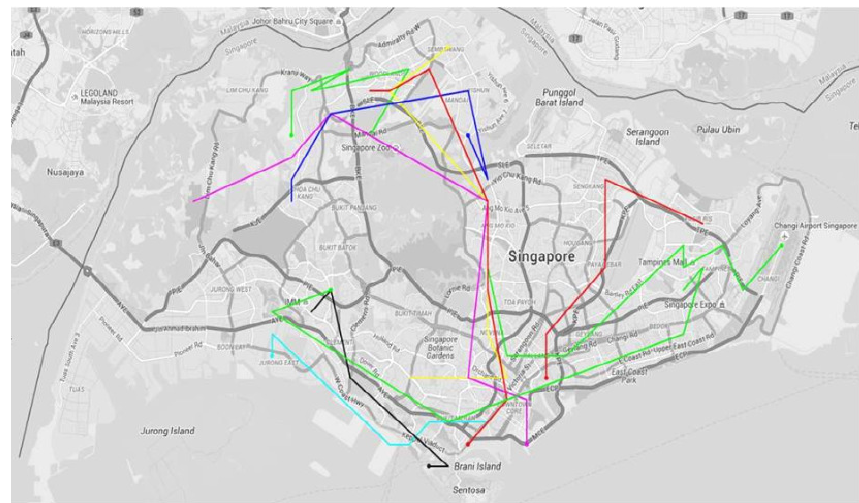
Figure 6. Ten clusters and their